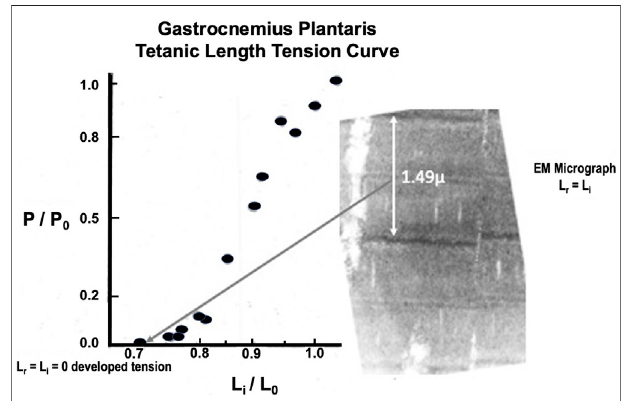
FIGURE 8 | Representative brief tetanic gastrocnemius length tension curve. The electron micrograph on the right was from a muscle fi xed at L r . Note that there is almost complete overlap of the actin and myosin myo fi laments in the sarcomere so that force generation is impossible.